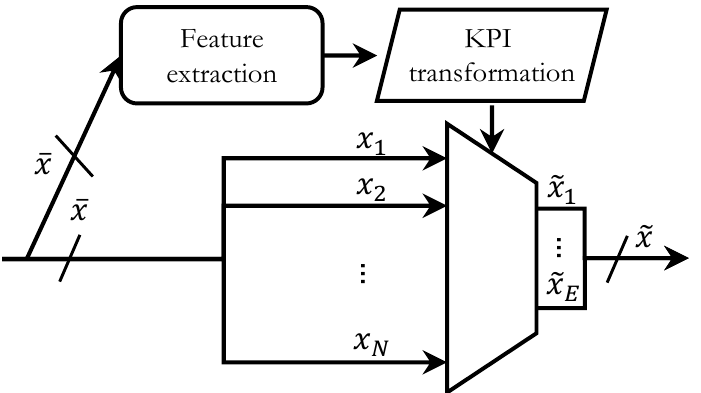
Figure 2. Scheme for feature extraction in the context of fault diagnosis functions. The upper branch represents the model creation during the learning phase (in this case, the KPI transformation to be applied), whereas the lower branch represents the application of such KPI